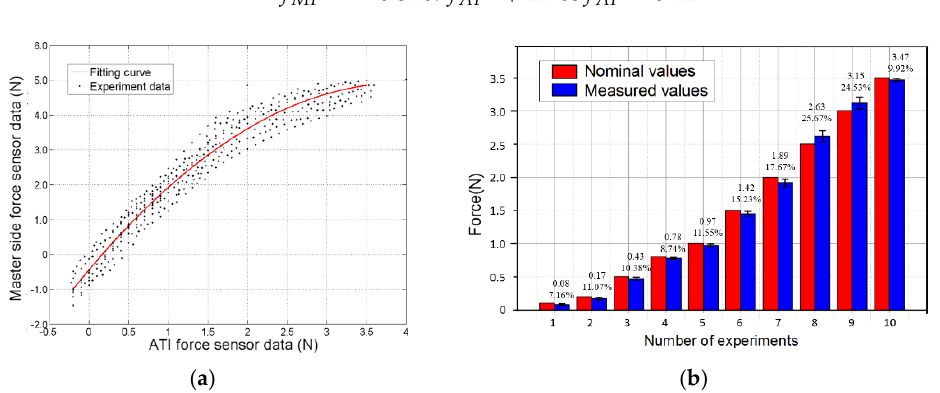
Figure 9. Force calibration experimental results. ( a ) Relationship between MF and AF. ( b ) Evaluation result of fitting accuracy in non-coaxial force transmission. The data displayed on the measured value are the average value and standard deviation based on multiple measurement results.